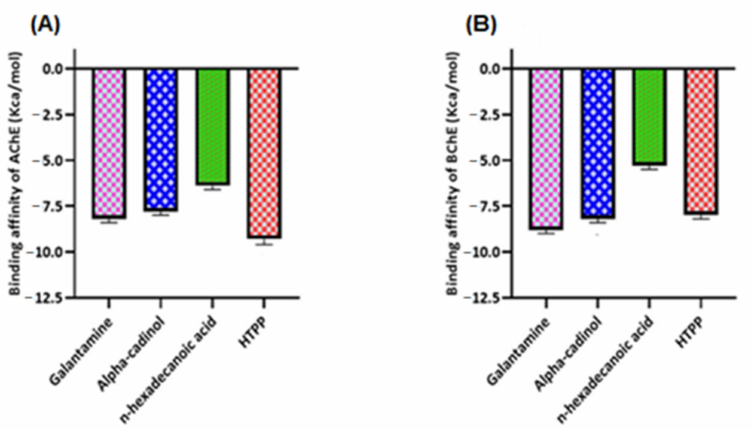
Figure 8. ( A ) Binding affinity of galantamine, alpha-cadinol, n -hexadecanoic acid, and N-hydroxy-N (cid:48) - [2-(trifluoromethyl)phenyl]pyridine-3-carboximidamide (HTPP) with acetylcholinesterase (AChE). ( B ) Binding affinity of galantamine, alpha-cadinol, n -hexadecanoic acid, and N-hydroxy-N (cid:48) -[2- (trifluoromethyl)phenyl]pyridine-3-carboximidamide (HTPP) with butyrylcholinesterase